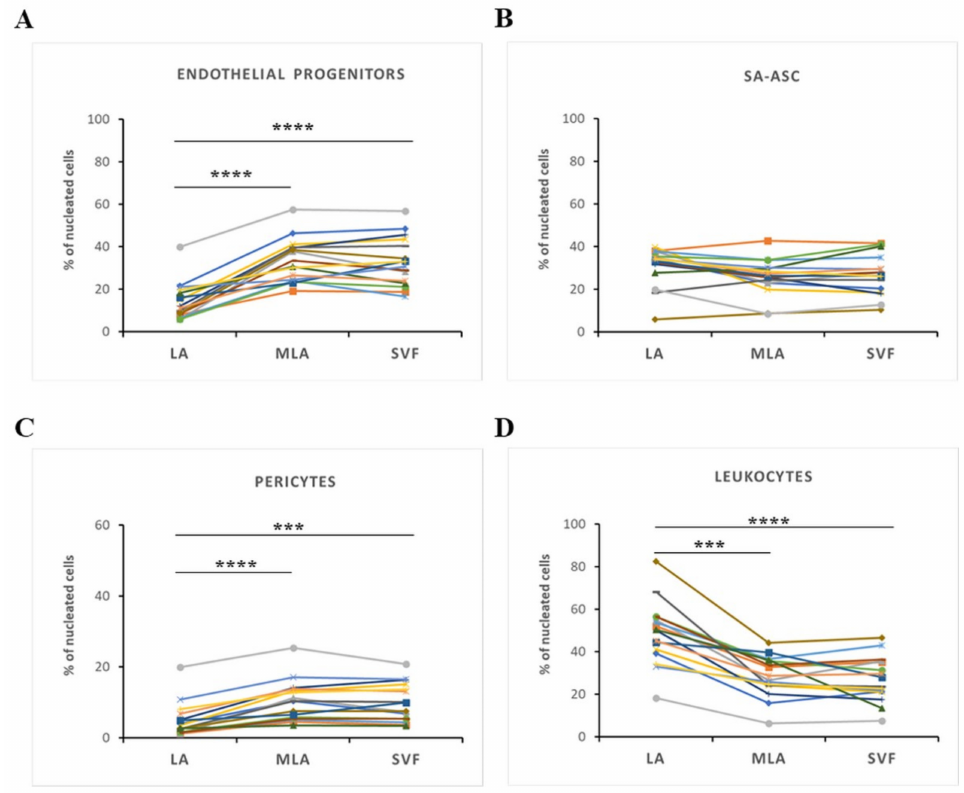
Figure 2. The main cell populations in stromal vascular fraction obtained from LA, MLA and SVF samples. The difference in the cell content between LA, MLA and SVF samples is shown as a percentage of nucleated cells for endothelial progenitors ( A ), SA-ASC ( B ), pericytes ( C ) and leuko- cytes ( D ) for each patient. Statistical analysis was performed using ordinary one-way ANOVA with Dunn’s multiple comparisons test ( A , D ) or Friedman’s multiple comparisons test ( B , C ). p -values: (***) p < 0.001, (****) p < 0.0001; n =